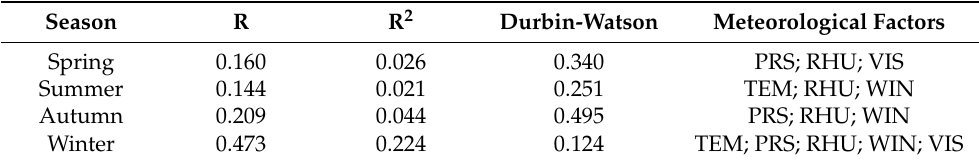
Table 2. Multiple linear regression analysis of meteorological factors and NAIs in different seasons.